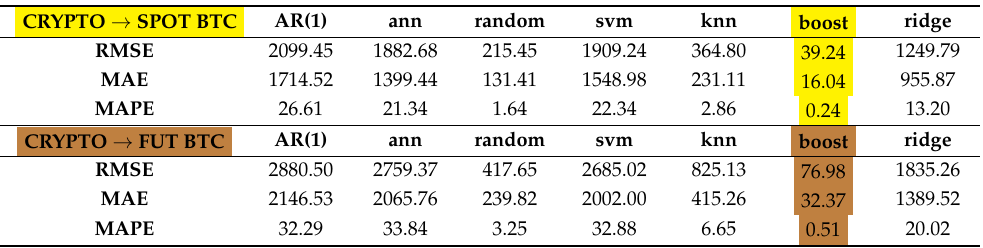
Table 5. Bitcoin Coinbase Spot and CME Futures Forecasts based on the most recent 17 cryptocurren- cies only from 24 January, 2018, to 11 December, 2019. CRYPTO → SPOT